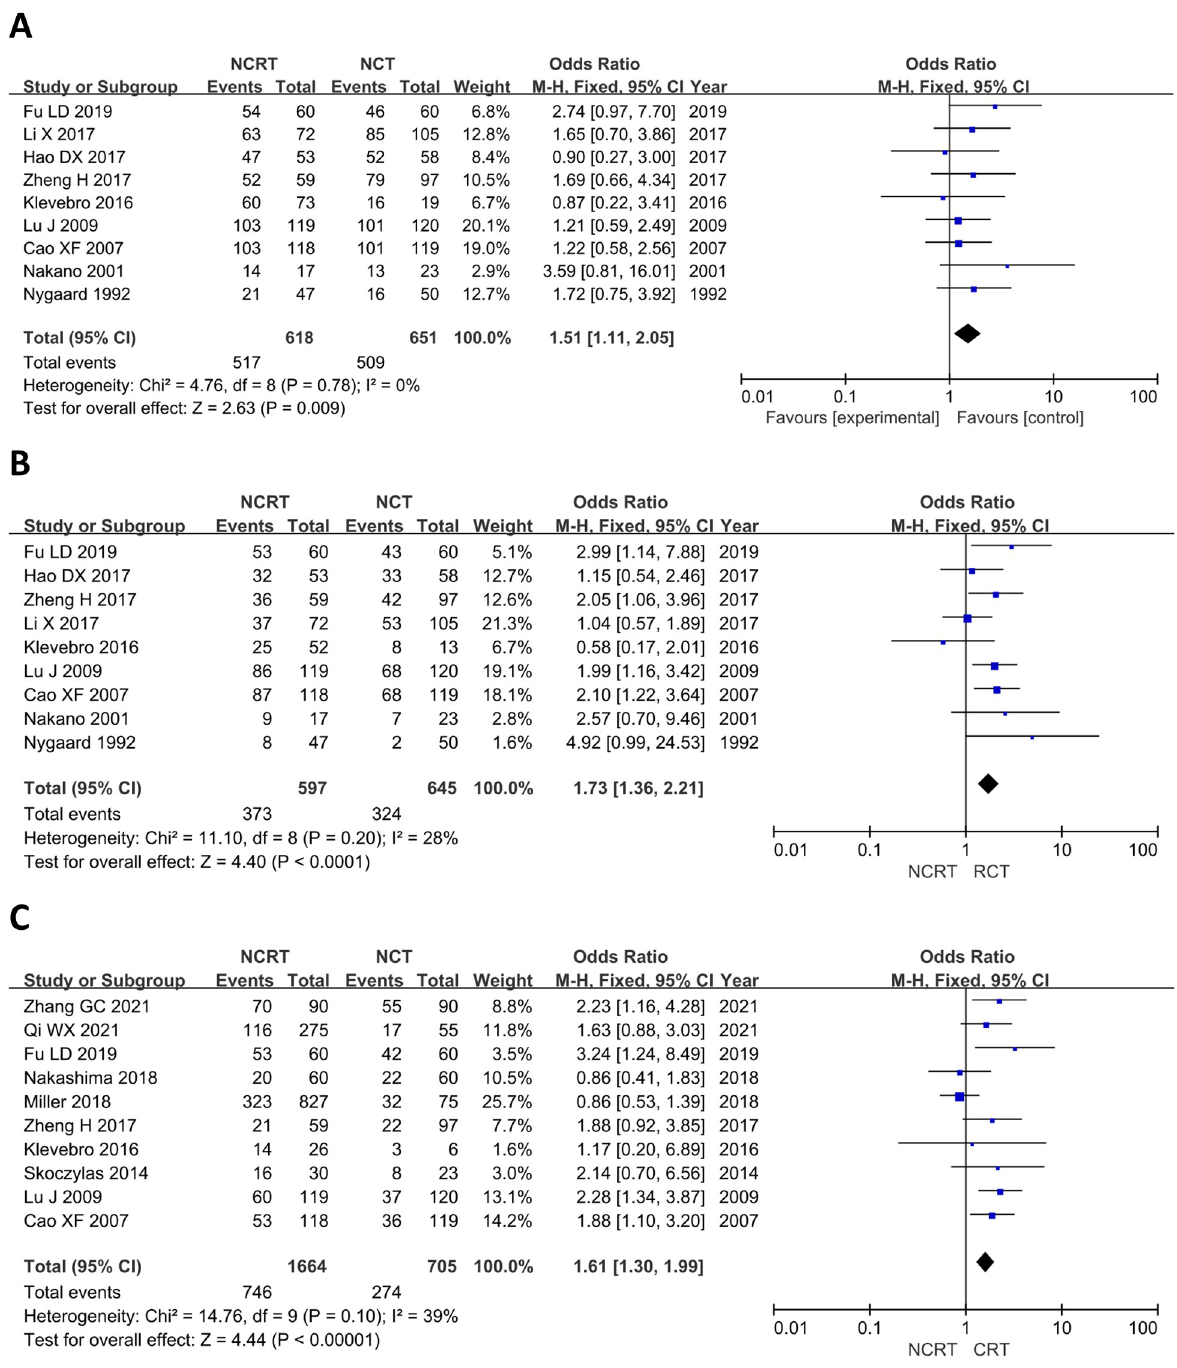
Fig 5. Forest plot for one-year (A), three-year (B), and five-year (C) survival rates of NCRT group and NCT group.